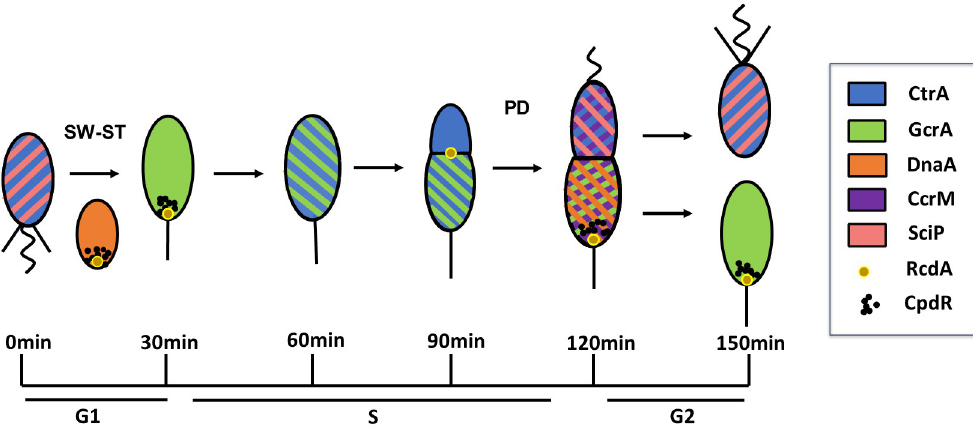
Fig 1. The asymmetric cell cycle of C. crescentus including G1, S, and G2 phases. C. crescentus cell grows in G1, replicates DNA in S phase, and prepares for cell division in G2 phase. The predivisional (PD) cell divides asymmetrically into two different progenies: motile swarmer (SW) cell and non-motile stalked cell (ST). The dynamics of CtrA, GcrA, DnaA, CcrM, SciP, RcdA, and CpdR is indicated by color during each stage of the cell cycle.